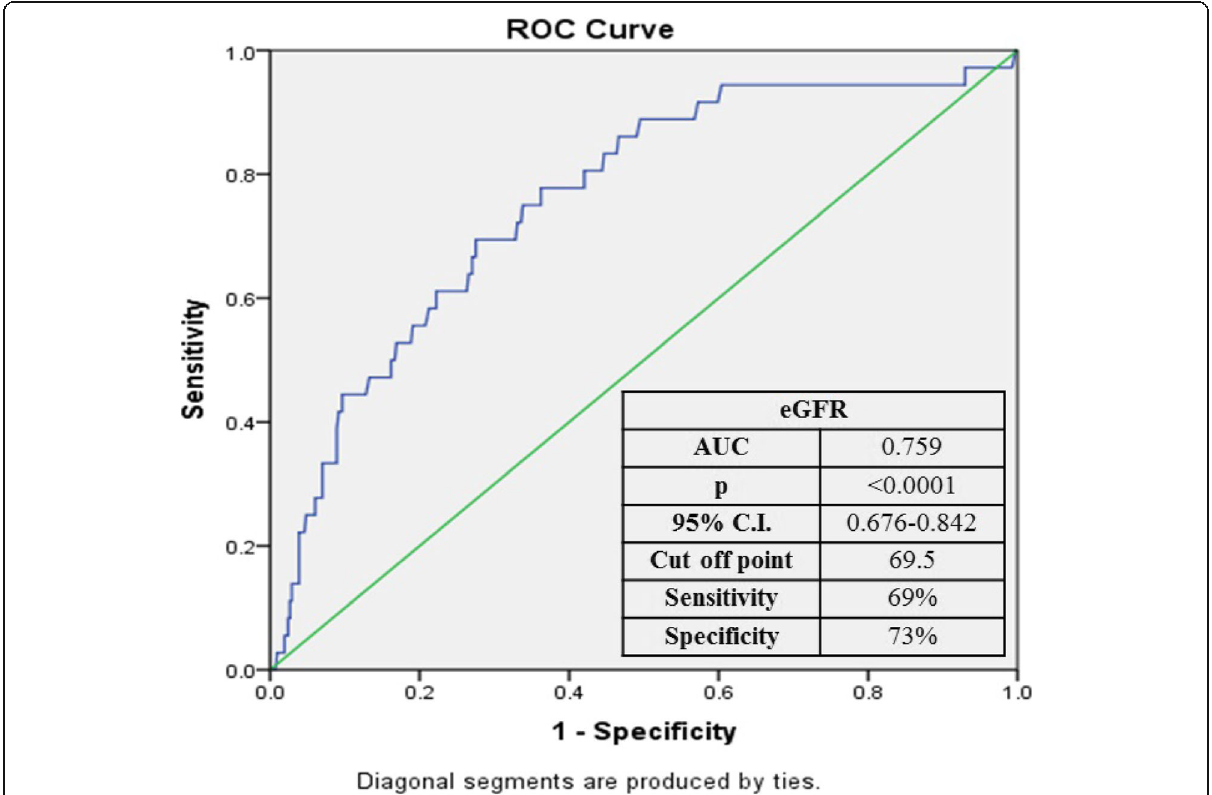
Fig. 1 ROC curve for eGFR as a predictor of mortality. eGFR, estimated glomerular filtration rate; CI, confidence